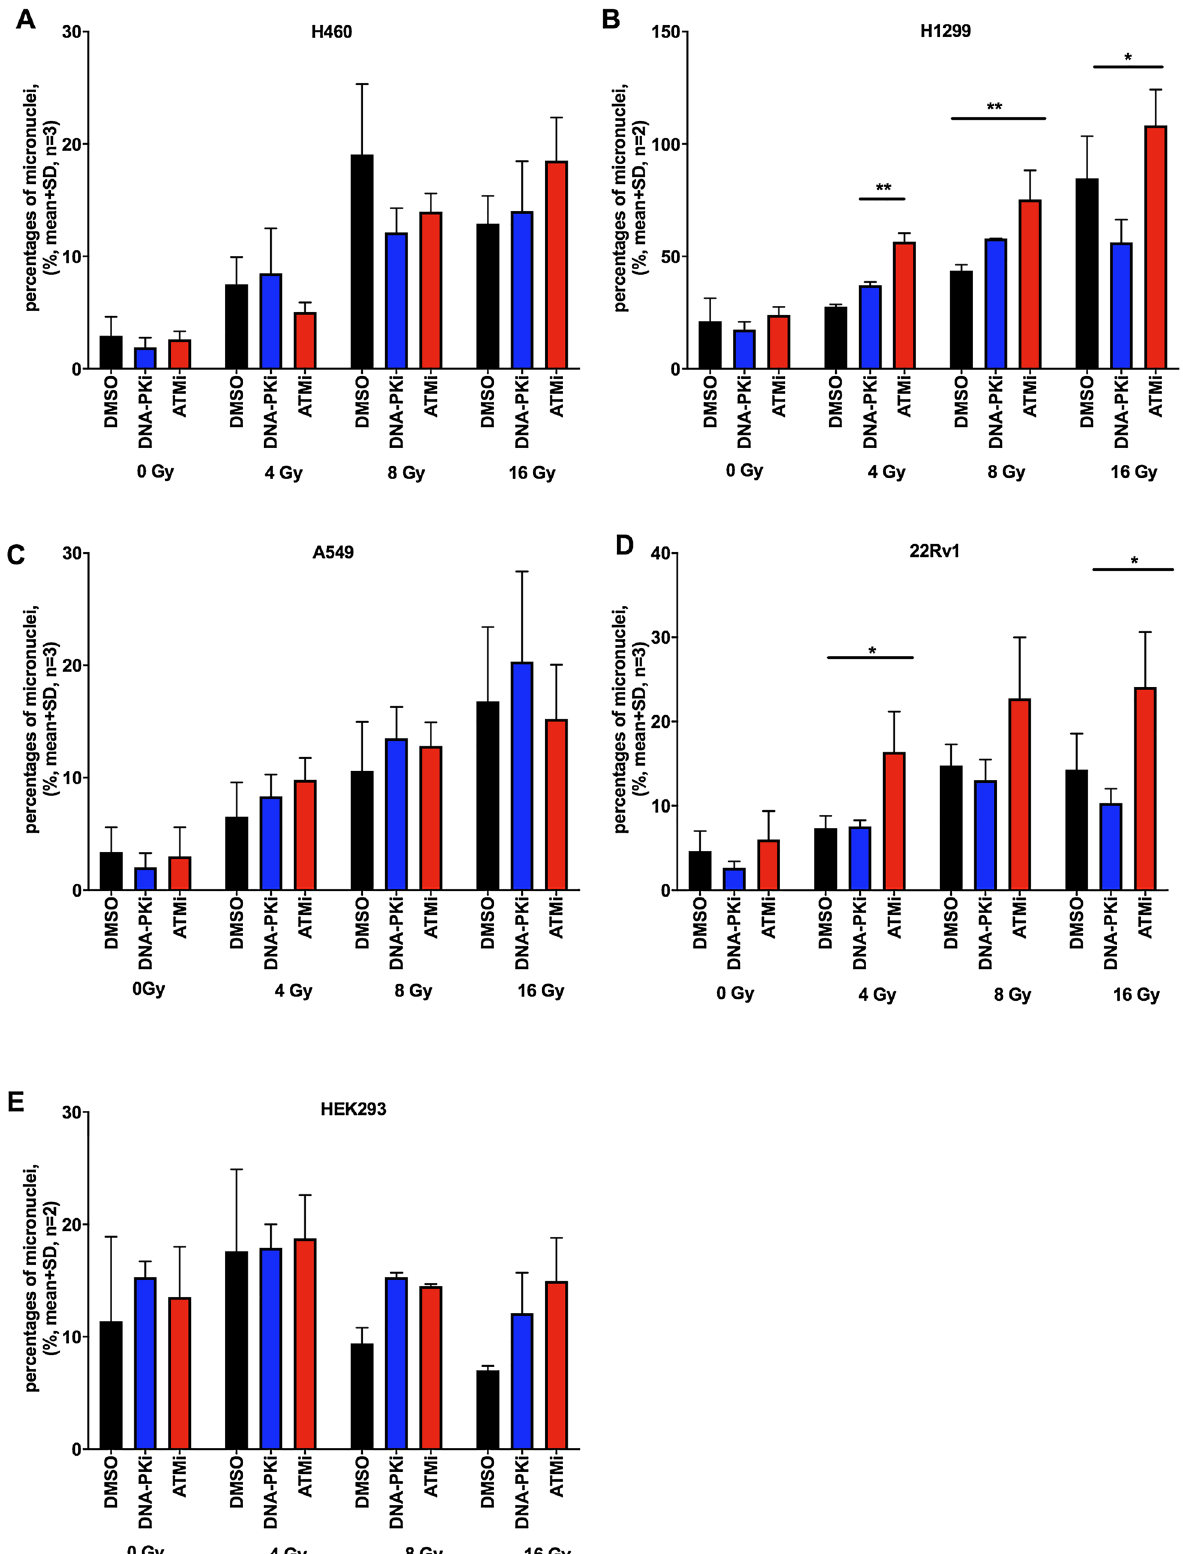
Figure 5. DDR inhibitors increased the formation of micronuclei after α-radiation in several cell lines. The micronucleus frequency for H460 cells ( A ), 22Rv1 ( B ), H1299 ( C ) and A549 ( D ) and HEK293 ( E ) treated with 200 nM DNA-PKi or ATMi for 2 h prior to α-radiation with activity of 1.3 kBq/cm 2 for 2, 4, 8 h, yielding doses of 4, 8 and 16 Gy incubated an additional 24 h (48 h for 22Rv1) before analysis; statistical analysis: 2way ANOVA, Dunnett’s multiple comparisons test: mean + SD, n ≥ 2, (*) p < 0.05, (**) p <